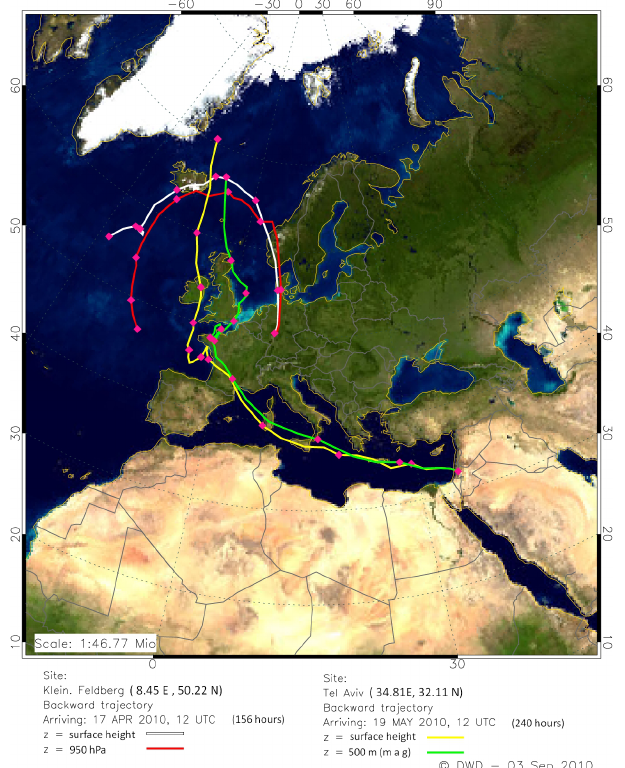
Fig. 2. Backward trajectories from Eyjafjallaj¨okull volcano arriving at Taunus Observatory in April 2010 and at Tel Aviv in May 2010. Trajectories were calculated by the German Weather Service DWD.